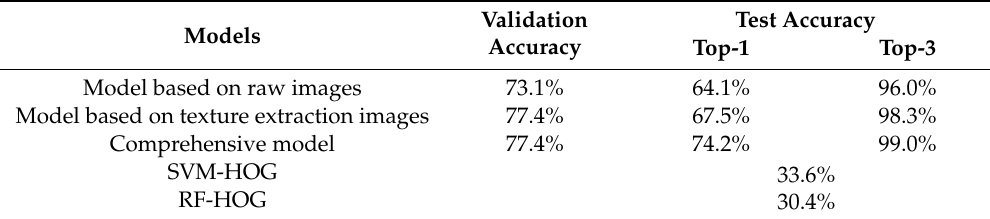
Table 4. Results of five models.